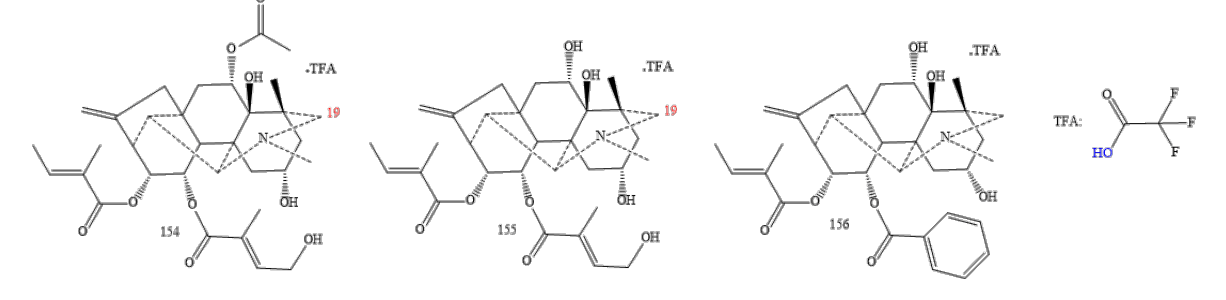
Figure 19. C 20 -anopterine DAs.